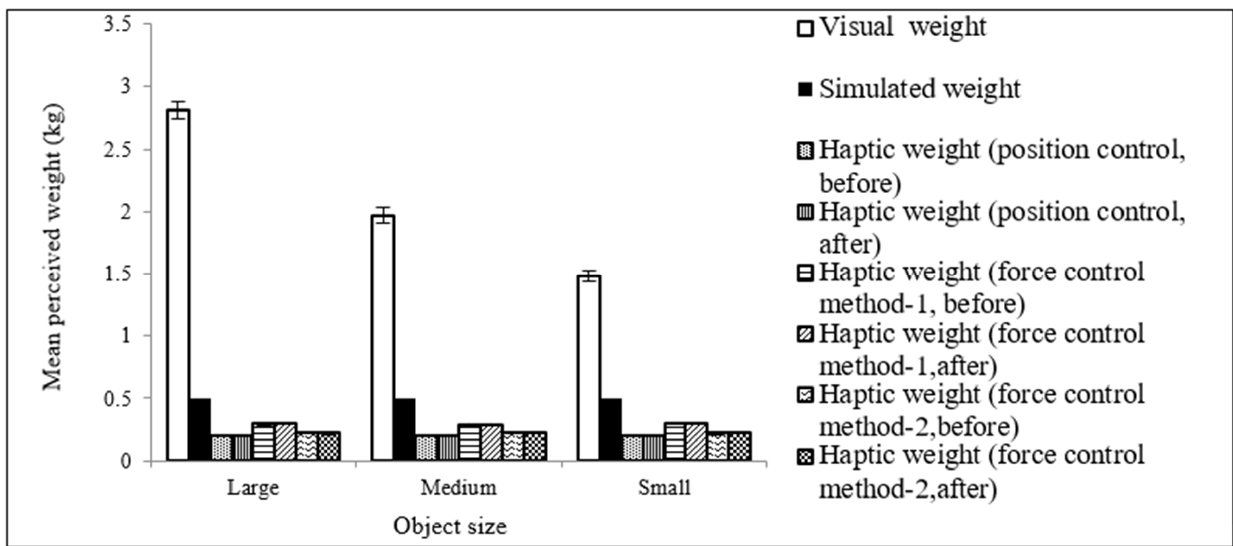
Figure 12. Mean (here, n = 20) weights (visually perceived, simulated, and haptically perceived) for the three control methods for different sizes of lifted objects before (experiment 1) and after (experiment 2) the implementation of the novel adaptive control